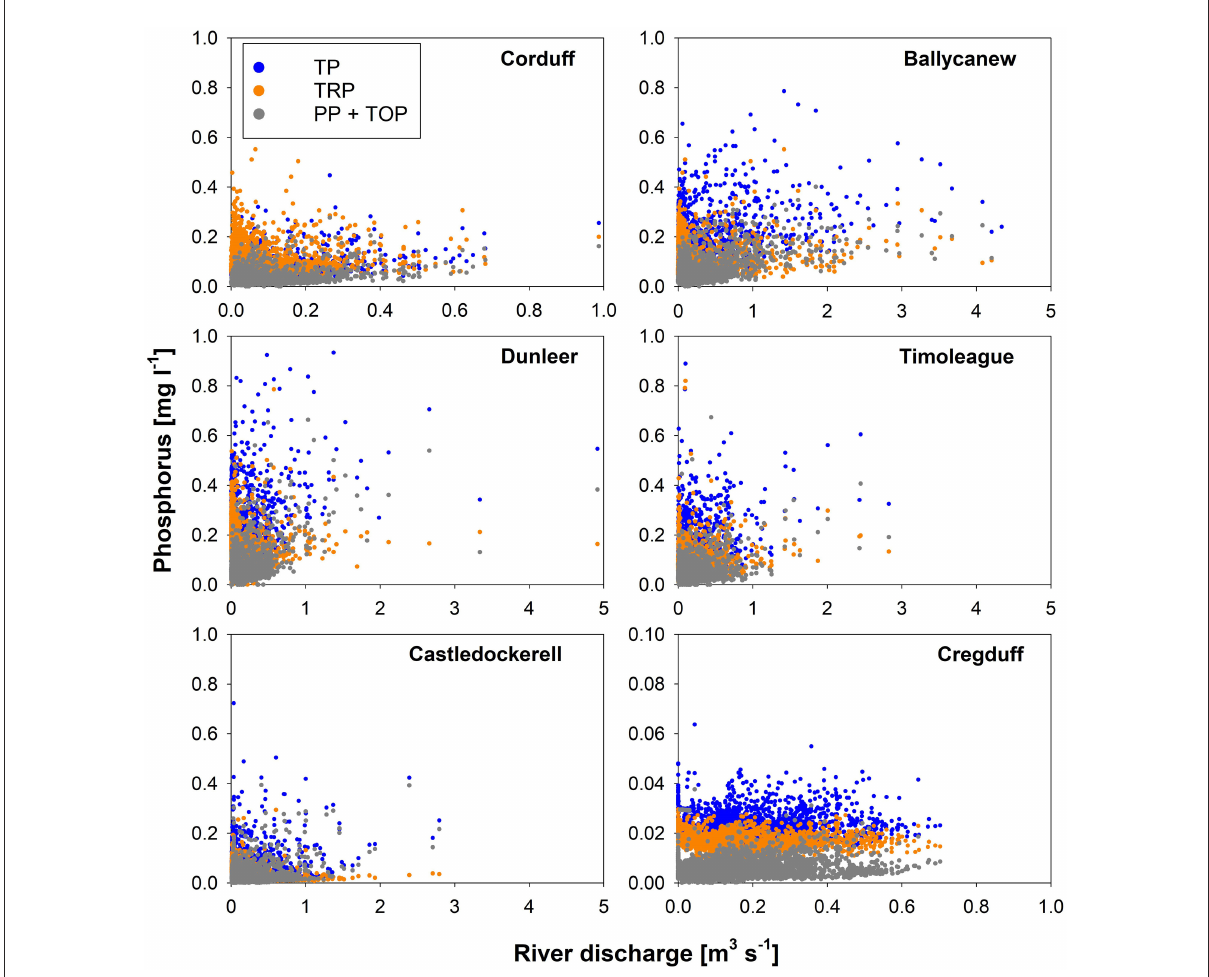
FIGURE6 Daily average river discharge and concentrations of TP, TRP and PP + TOP for 10 years (1st October 2010 to 30th September 2020) in the six study